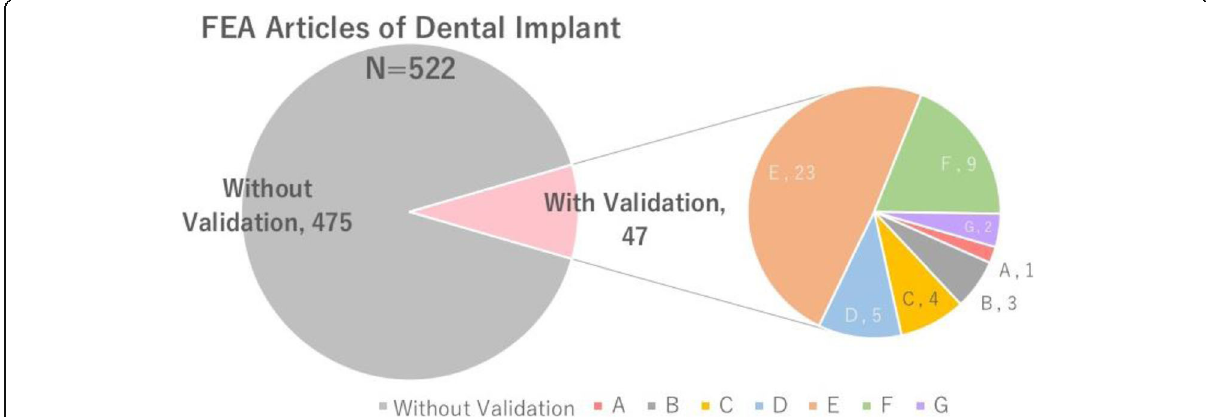
Fig. 3 Proportion of dental implant FEA articles with a validation. ( Left ) Among totally 522 FEA articles of dental implants which we were able to access English full text up to January 2017, there are only 47 articles with a validation. ( Right ) The articles with a validation were categorized according to their validation method as follows levels: A, in vivo (human bodies); B, performed in vivo (heterogeneous animals); C, model experiment performed using part of a cadaver; D, model experiment performed using heterogeneous bone; E, model experiment performed using artificial materials; F, comparison with past literature; and G, performed with other software ( n =